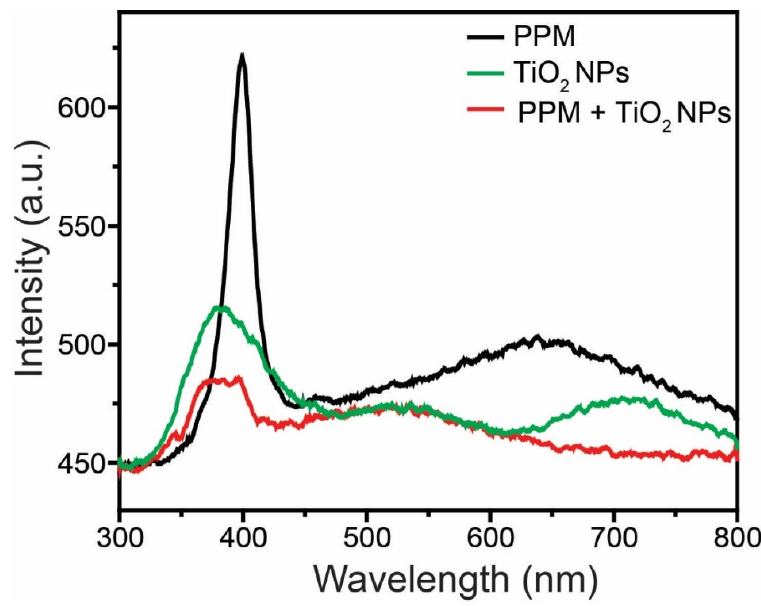
Figure 9. PL spectra of PP membrane, TiO 2 NPs, and PPM + TiO 2 NPs.